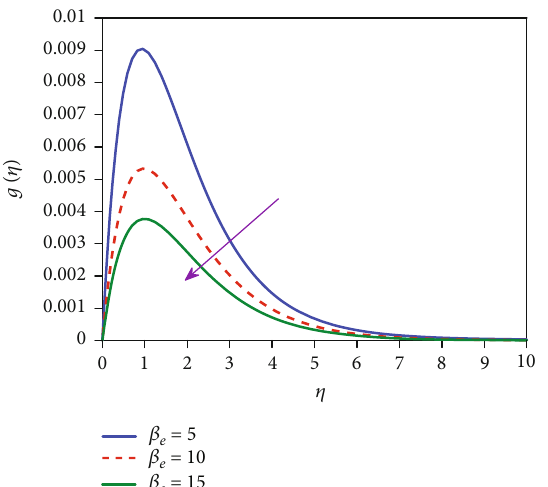
on the secondary velocity g ð η Þ e